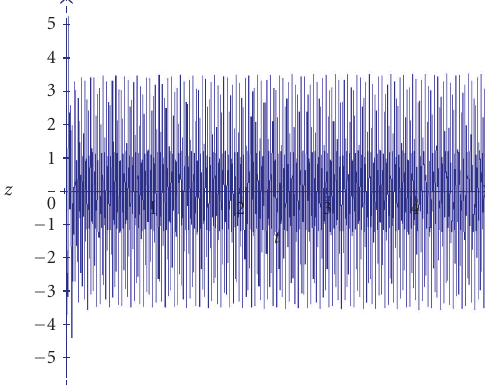
Figure 6.17 . Bounded solution of (5.2) in the point S (810,170), a 0 = 5.